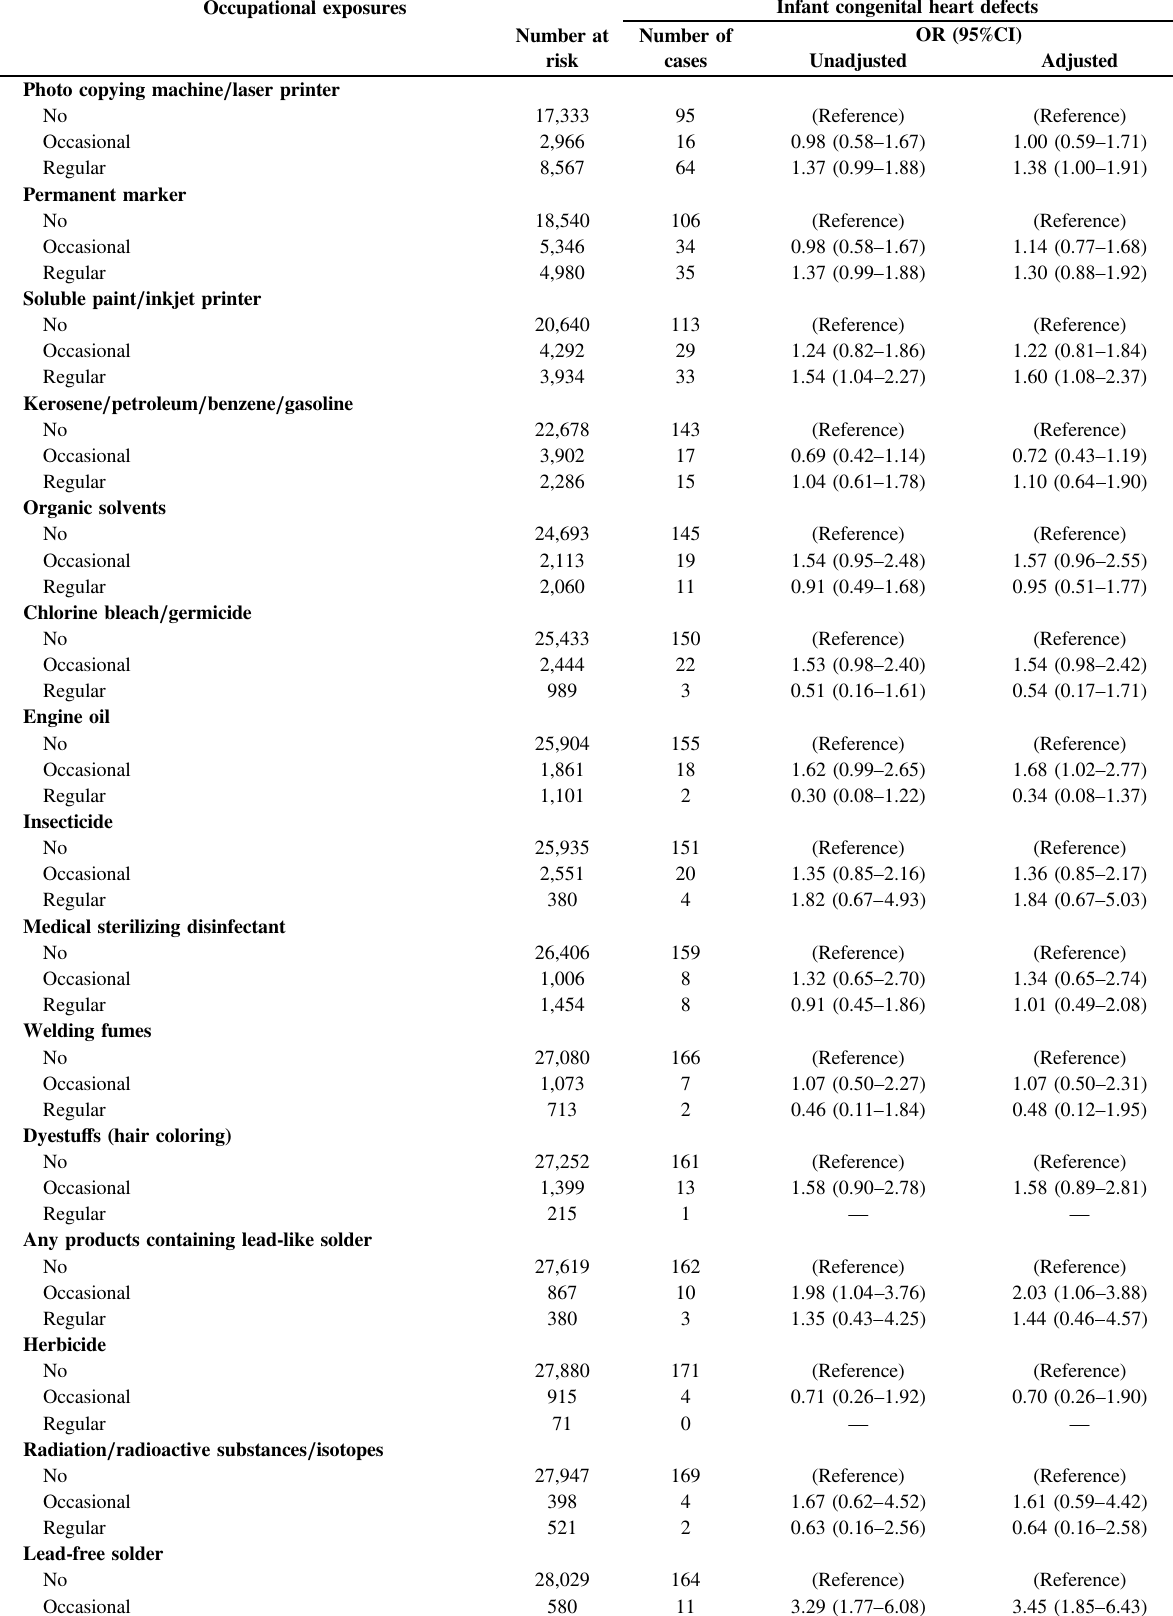
Table 2 Associations between paternal occupational exposures and the risk of infant congenital heart defects Occupational exposures Infant congenital heart